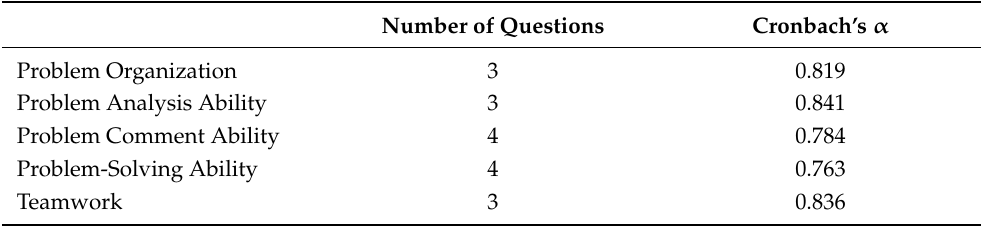
Table 2. Cronbach’s α of the question in the questionnaire survey.